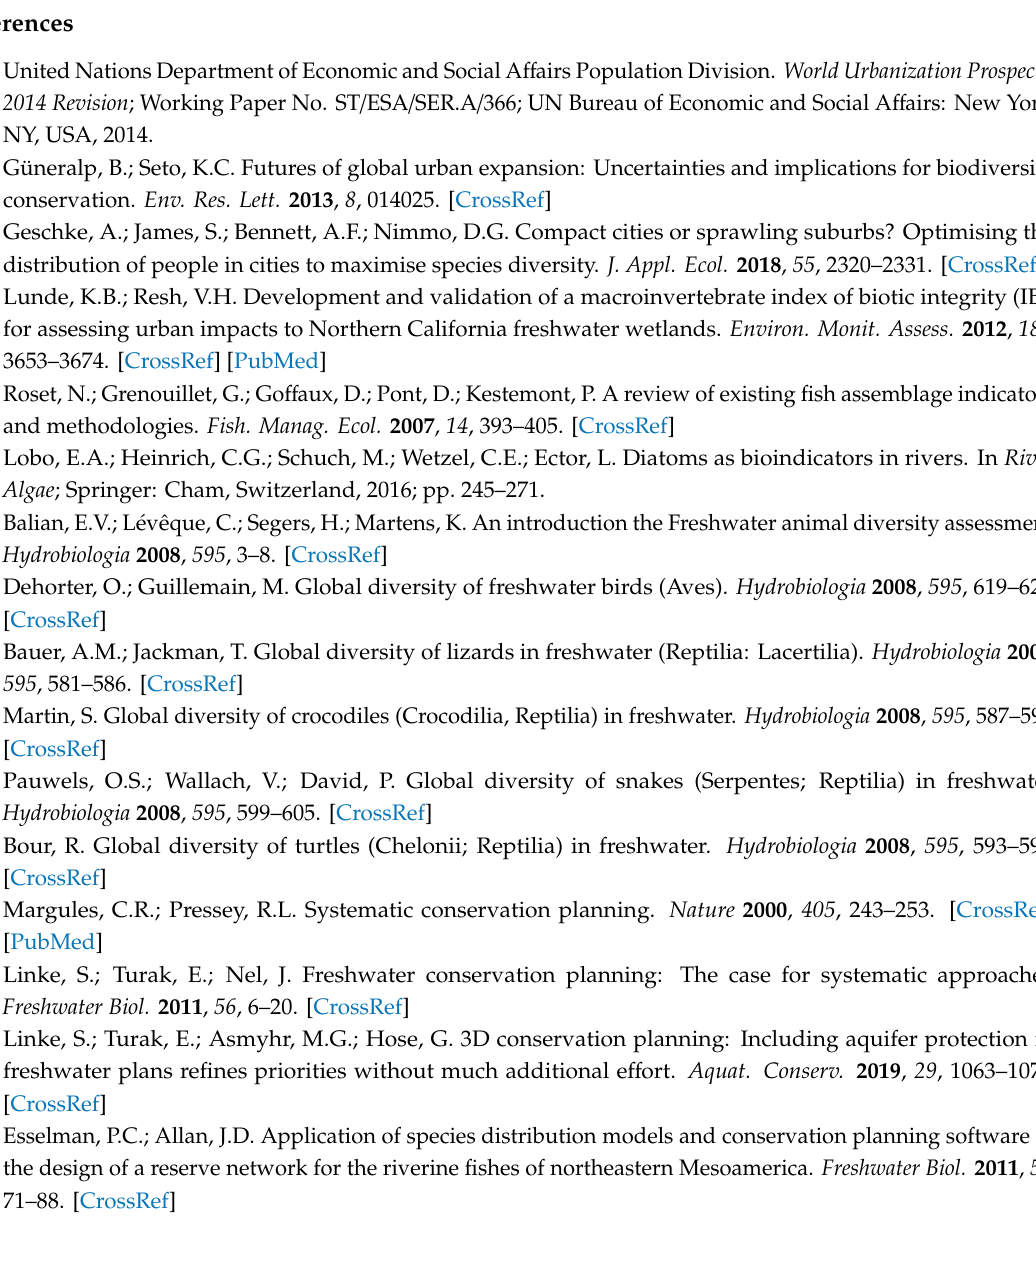
Table S1: Freshwater dependent reptile species, Table S2: Cities of the World with a population greater than 100,000, Table S3: Number of species and sightings of freshwater reptiles and observation near cities in Each Freshwater Ecoregion of the World, Table S4: Environmental variables dataset for habitat suitability